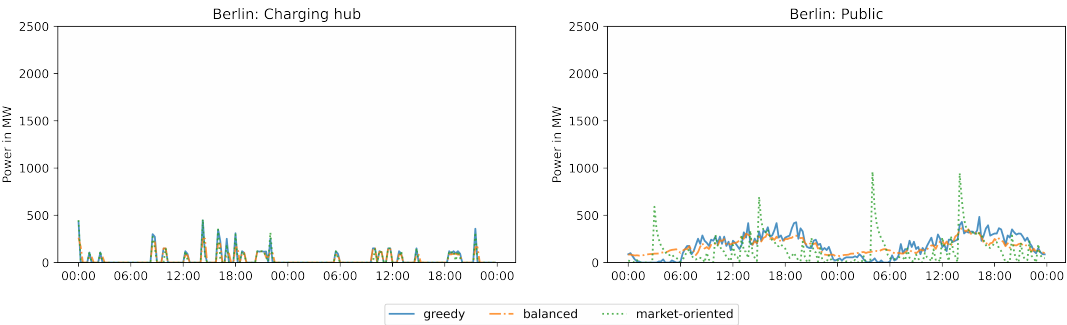
Figure 6. Load profile for each charging strategy in Berlin for 2 days in the public